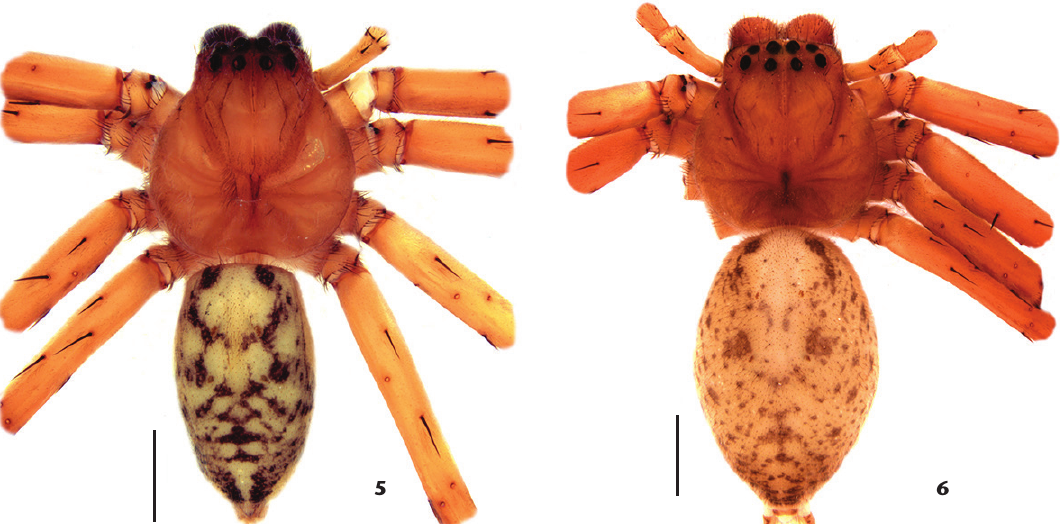
Figures 5-6. Dorsal habitus. Nungara niveomaculata (Mello-Leitão, 1941) comb. nov. (1) male, MNRJ 43275, (2) female, MNRJ 13331. Scale bars: 1